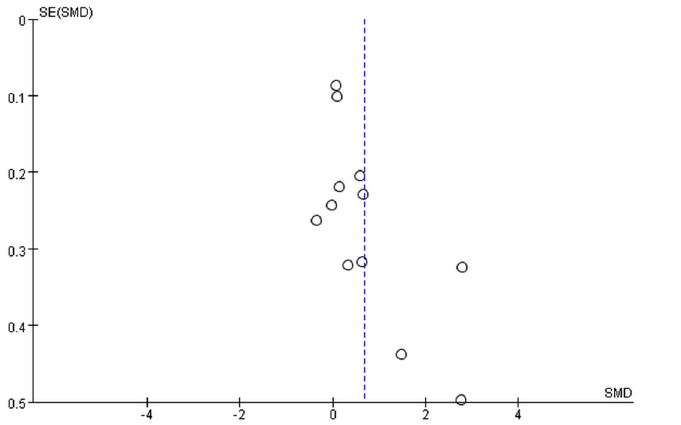
Fig 5. Funnel plot of the meta-analysis.